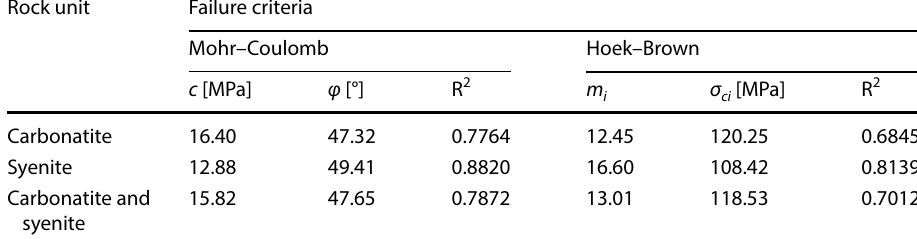
Table 8 The values of Hoek– Brown and Mohr–Coulomb failure